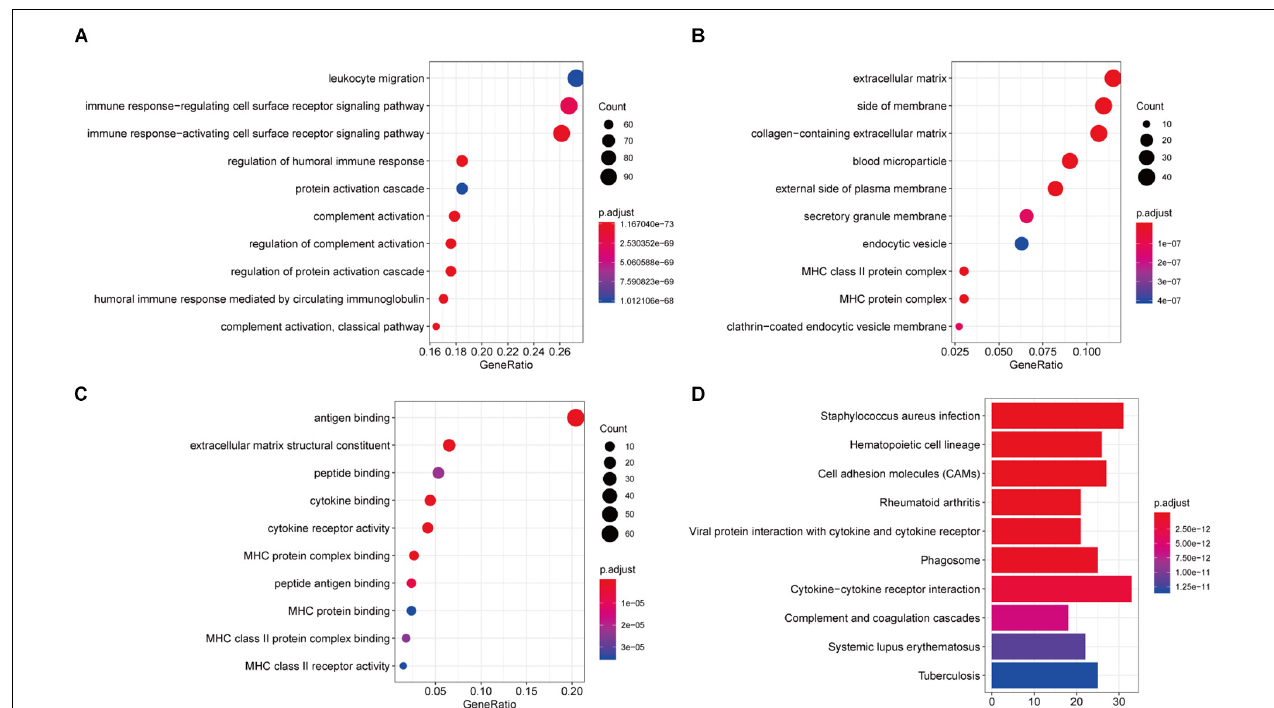
FIGURE 4 | Function richness analysis of immune-related genes in recurrent HNSCC. (A) The biological process (BP) of genetic ontology (GO) of prognostic immune-related genes. (B) Cellular components of the gene ontology (GO) of prognostic immune-related genes. (C) The molecular function (MF) of the GO of prognostic immune-related genes. (D) Kyoto Encyclopedia of Genes and Genomes (KEGG) pathway enrichment analysis of prognostic immune-related genes. The color of the bar indicates –log10 ( p -value). The intersection of the KEGG pathway and GO Term is enriched by the number of